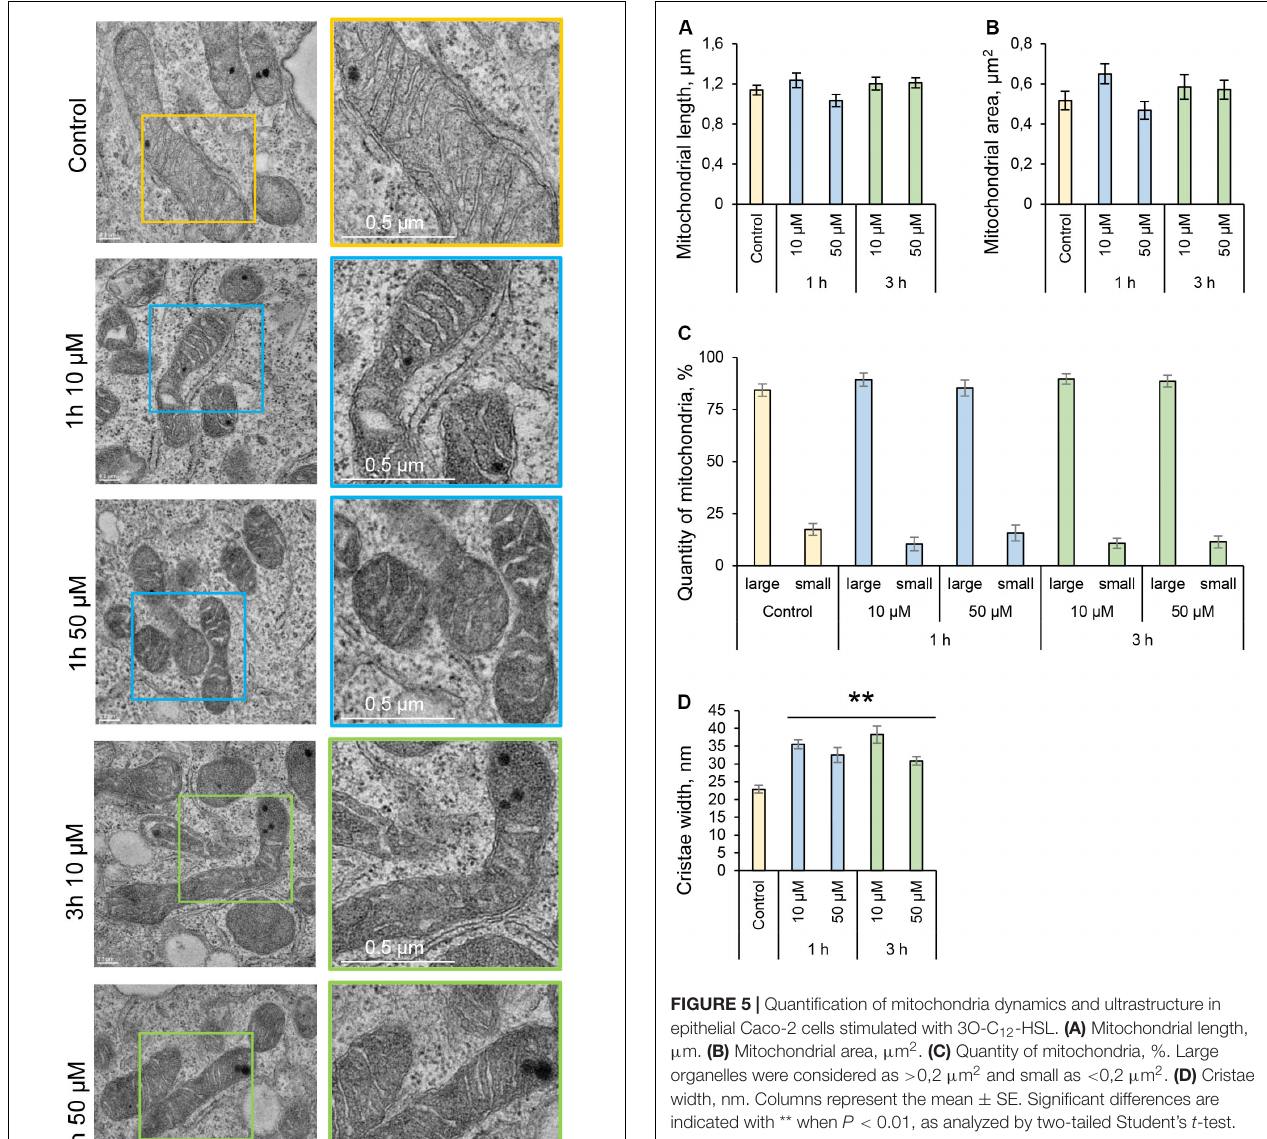
the epithelial monolayers also displayed a distinct time- and dose-dependent pattern, which however was not so dramatic as in the fibroblasts ( Figures 8A,B ). Thus, 3O-C 12 -HSL-treatment resulted in depletion of MMP in both cell types supporting perturbed mitochondrial function ( Figure 9 ).